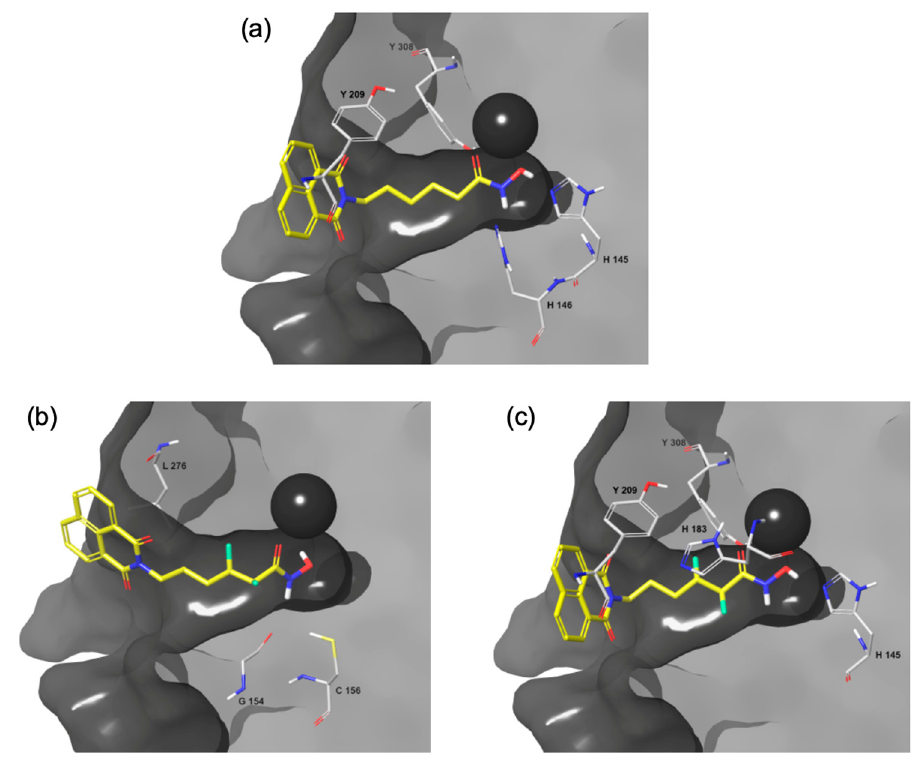
Figure 5. Predicted binding poses of Scriptaid analogs to HDAC2. ( a ) Ligand 7 ; ( b ) ligand 8 ; ( c ) ligand 9 .